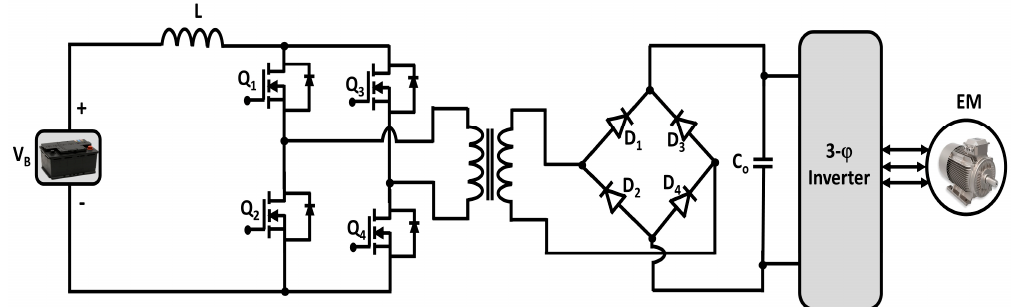
Figure 25. Isolated Full-bridge Boost DC–DC Converter.